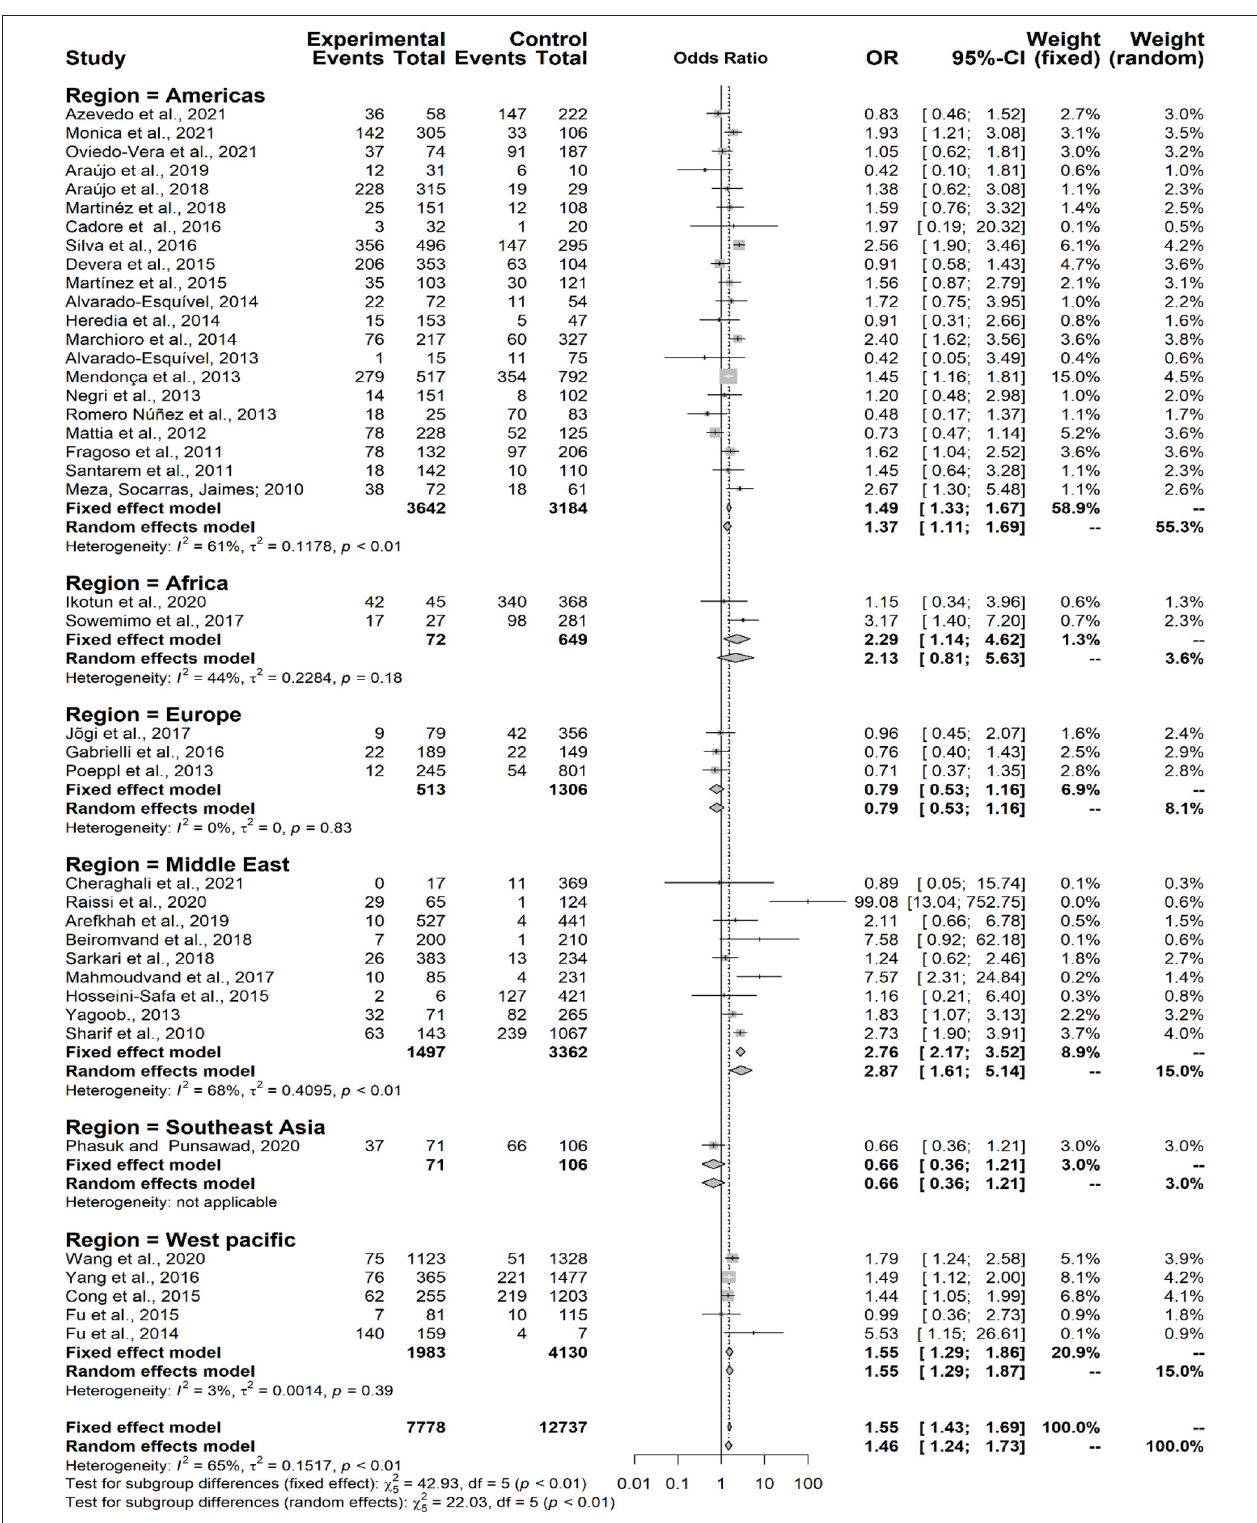
FIGURE 7 | Forest plot for assessment of odds-ratio of influence of anti- Toxocara spp. antibodies in different world geographical regions (WHO- World Health Organization), according to selected articles used in the meta-analysis from 2009 to 2021.